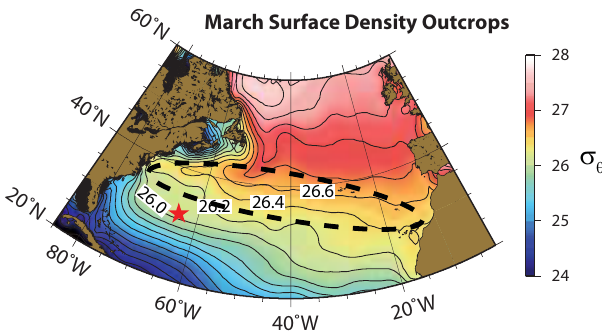
Fig. 6. March surface density outcrops, as calculated from temper- ature and salinity data from the World Ocean Atlas (Antonov et al., 2009; Locarnini et al., 2009) for the North Atlantic. The location of the BATS site is marked by a red star. Integrated AOUR in the up- per 500m calculated at BATS is reflective of the region of outcrop of density surfaces of 26.3 to 26.6kgm − 3 , roughly indicated by the black dashed